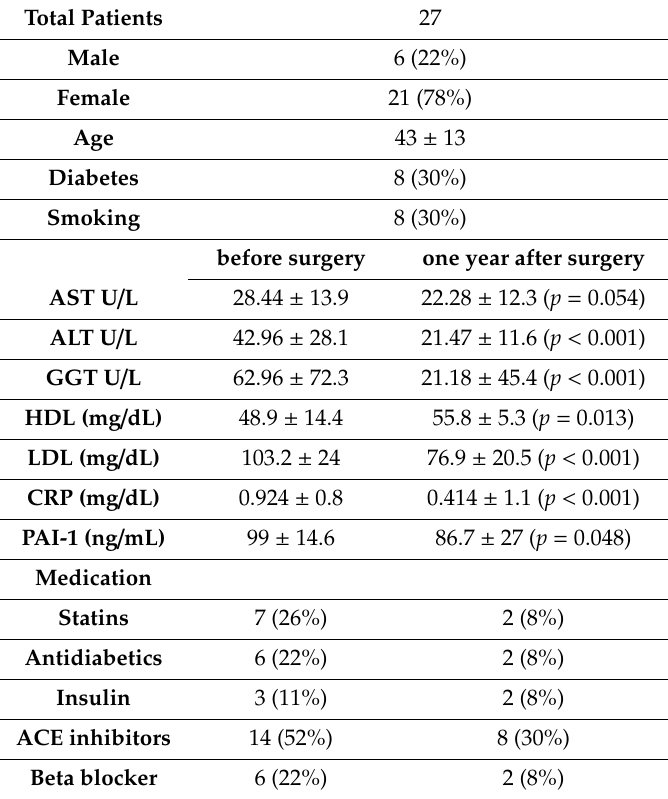
Table 1. Patient